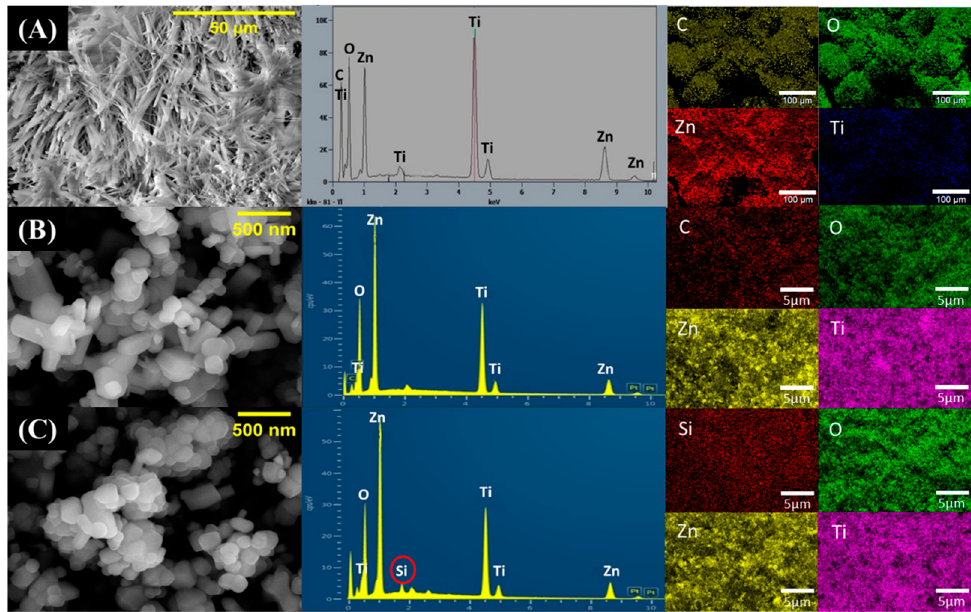
Figure 2. Scanning electron microscopy images and energy-dispersive X-ray spectra of ( A ) ZnO– TiO 2 –TEA, ( B ) ZnO–TiO 2 , and ( C ) ZnO–TiO 2 –silane. As shown in Figure 3A, all of the samples were synthesized ZnO particles with a hexagonal wurtzite crystal structure with XRD peaks of ( 2 θ , reflection plane ) = ( 31 . 8°, ( 100 )) , ( 34 . 5°, ( 002 )) , ( 36 . 3°, ( 101 )) , ( 47 . 5°, ( 102 )) and ( 56 . 6°, ( 110 )) and were uniformly